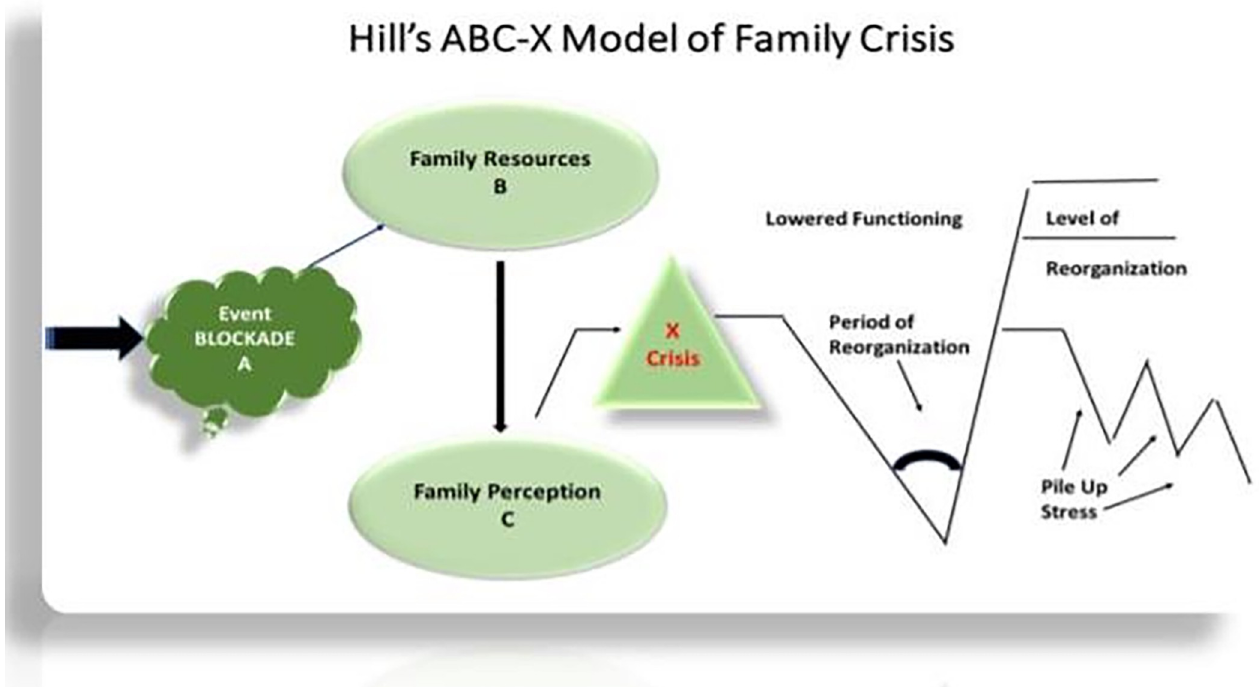
Fig 1. Hill’s ABC-X Model of Family Crisis. Event (A) filters through Family Resources (B) and Family Perception (C) to determine the experience of the Crisis (X). Following the crisis, a period of reorganization occurs at the lowest point of functioning, then level of reorganization rises with level of functioning, while pile up stress occurs in the